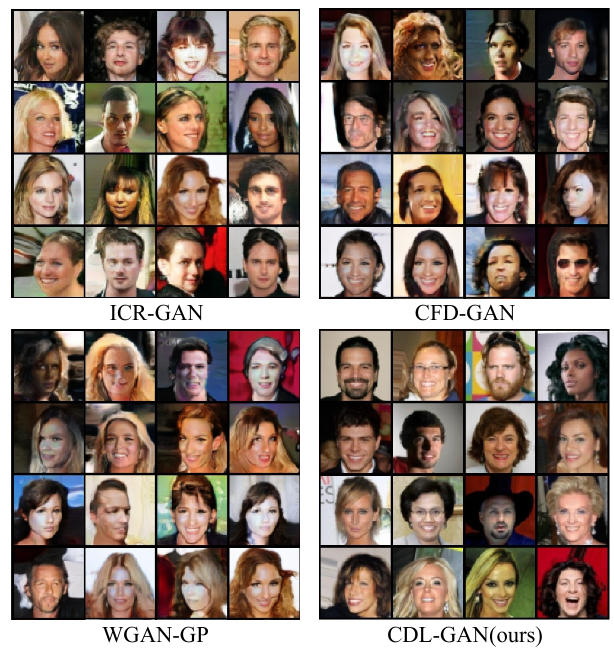
Figure 7. Image samples from different models on CelebA dataset.